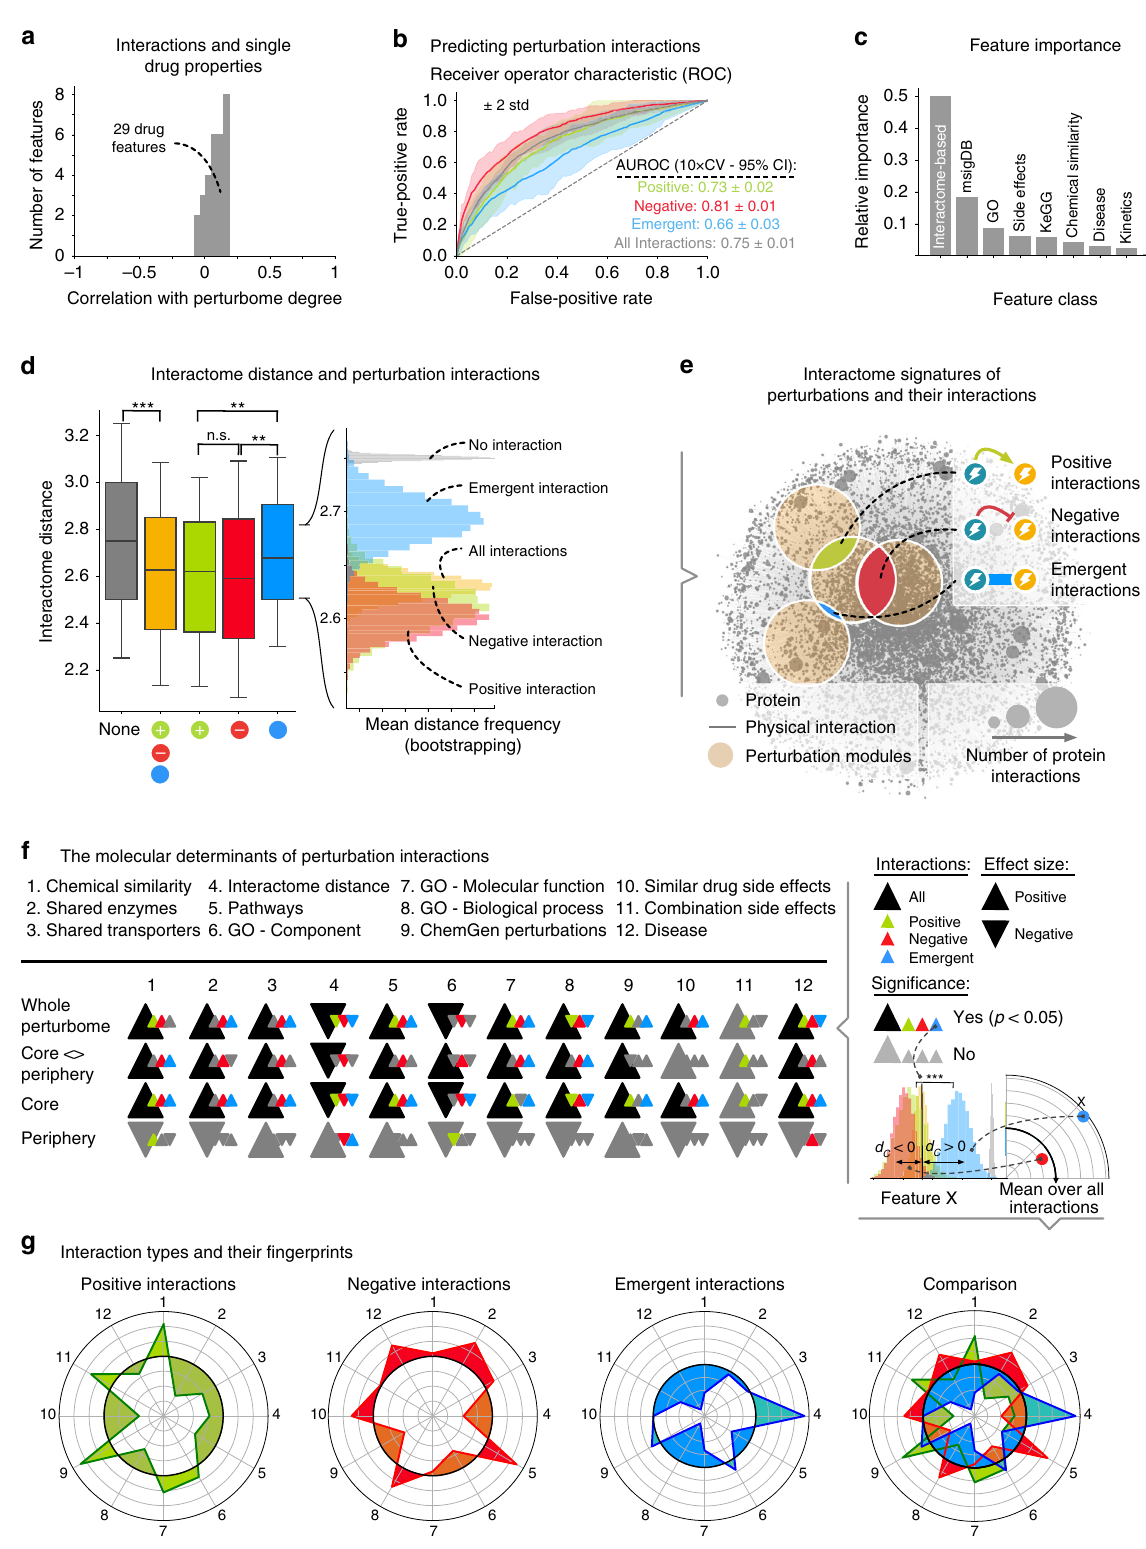
interaction types, whereas negative interactions have a unique peak for shared pathways, while emergent interactions are characterized by a distinctive spread on the interactome (Fig. 5g, green, red, and blue curves, respectively). Taken together, these discriminatory features provide a rich resource for further dissecting the different drug – drug interaction types.